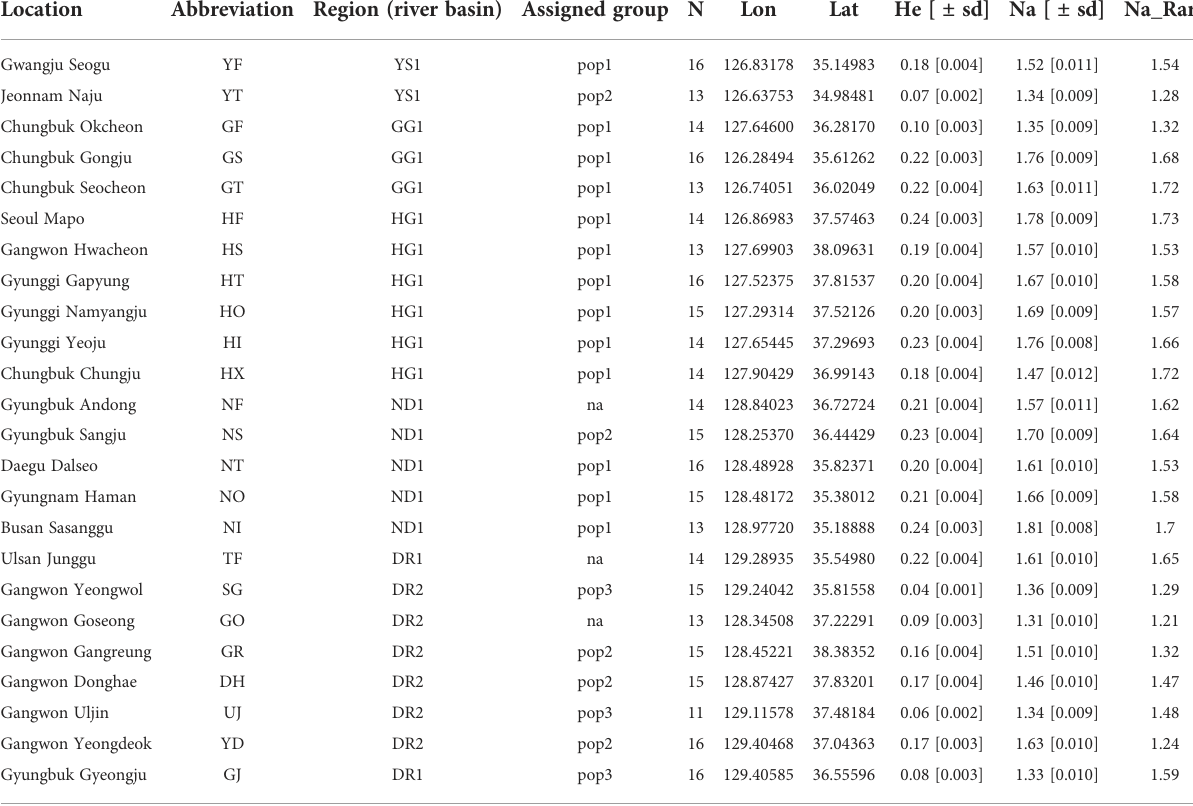
TABLE 1 Locality information of burcucumber collection sites in South Korea. Location Abbreviation Region (river basin) Assigned group